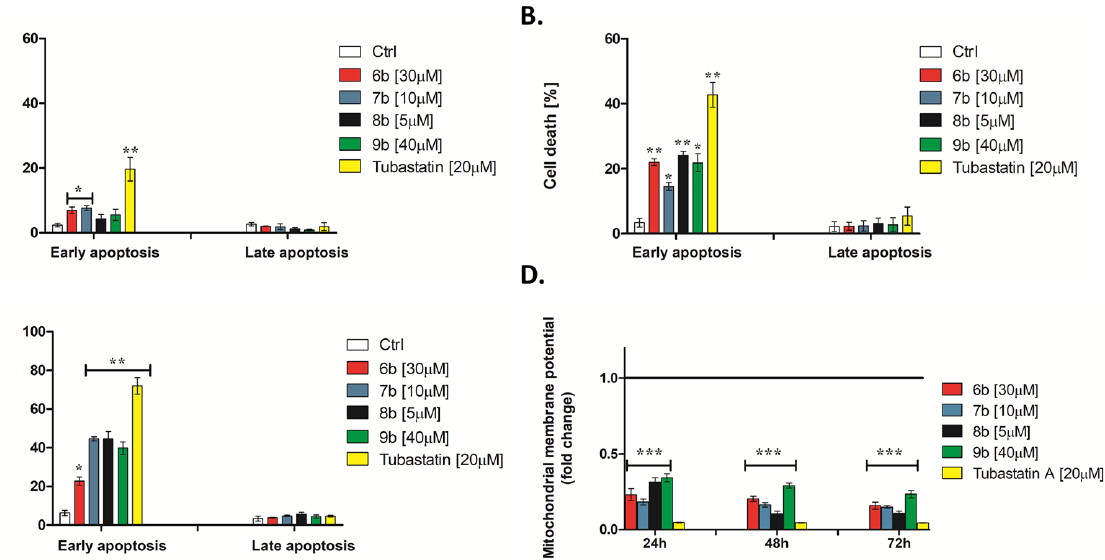
Figure 4. Newly synthesized HDAC inhibitors activate the intrinsic cell death pathway. The proportion of early apoptotic and late apoptotic MDA-MB-231 cells was measured using bivariate Annexin V/7AAD analysis by flow cytometry after the cells underwent treatment with tested compounds at IC 50 concentration for ( A ) 24 h, ( B ) 48 h, and ( C ) 72 h. ( D ) Dissipation of mitochondrial membrane potential was assessed by flow cytometry using JC-1 dye (compared to the untreated control). Significant differences between treatments were determined by t -test: * p ≤ 0.05, ** p ≤ 0.01, *** p ≤ 0.001 (compared to the untreated control).